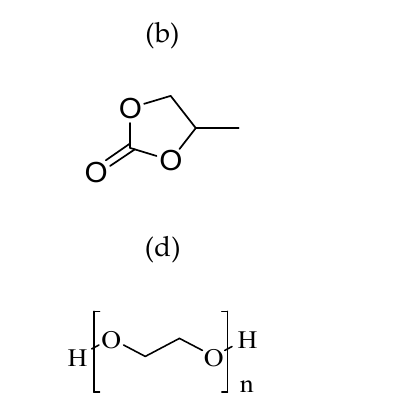
Figure 13 . Plasticiser chemical structure of ( a ) ethylene carbonate; ( b ) propylene carbonate; ( c ) dimethyl carbonate; ( d ) polyethene glycol .